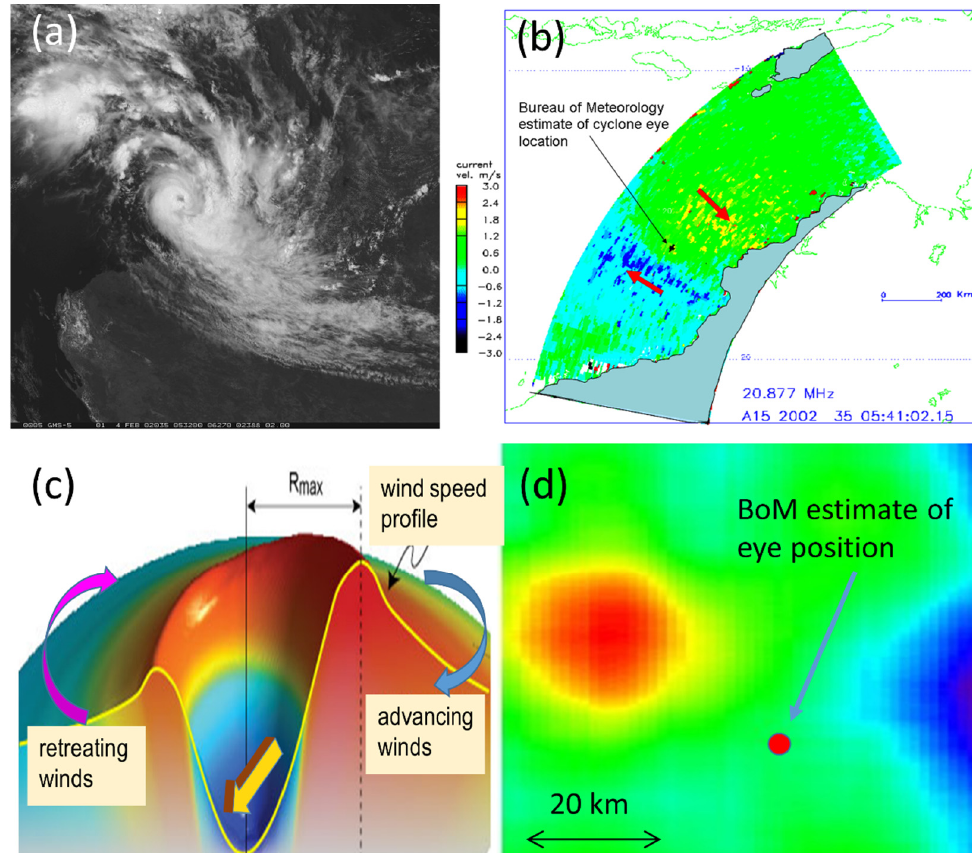
Figure 46. Prospective vorticity analysis of Tropical Cyclone Chris, 2002. ( a ) Composite VISSR image of TC Chris on 4 February 2002, ( b ) Jindalee skywave radar map of radial current speed, ( c ) model of the wind speed asymmetry about the direction of motion, ( d ) map of prospective vorticity showing the discrepancy between cloud-based location as derived by the Australian Bureau of Meteorology and the peak value of prospective vorticity.